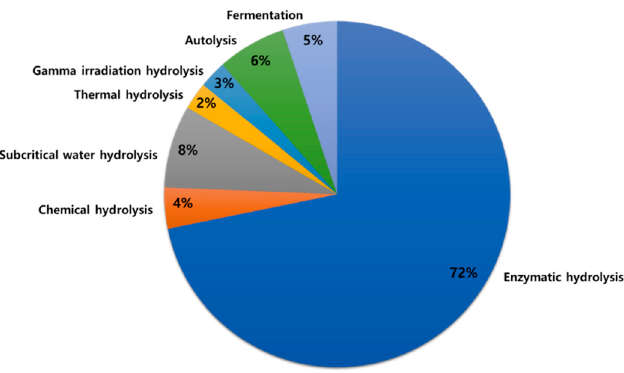
Figure 1. Current methods of producing marine animal-based protein hydrolysates and